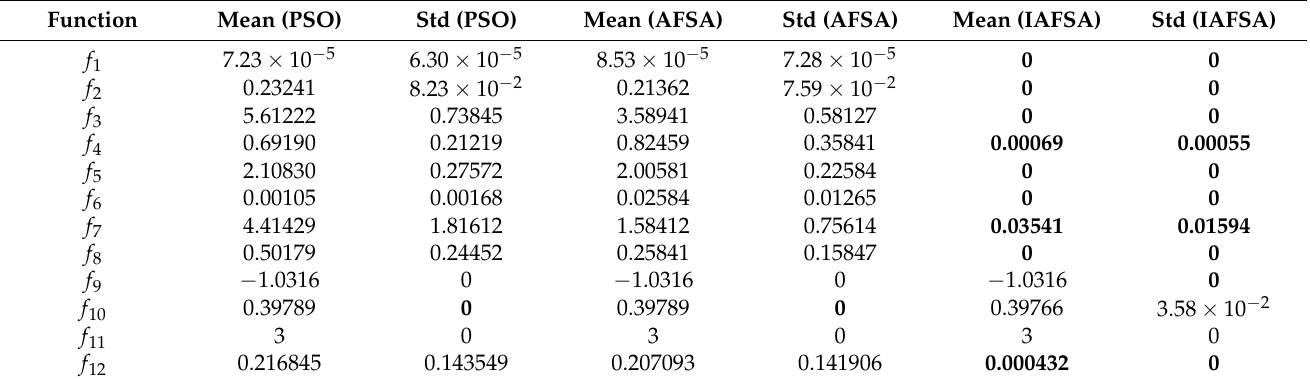
Table 2. Result of the benchmark function test (each function was executed 50 times).